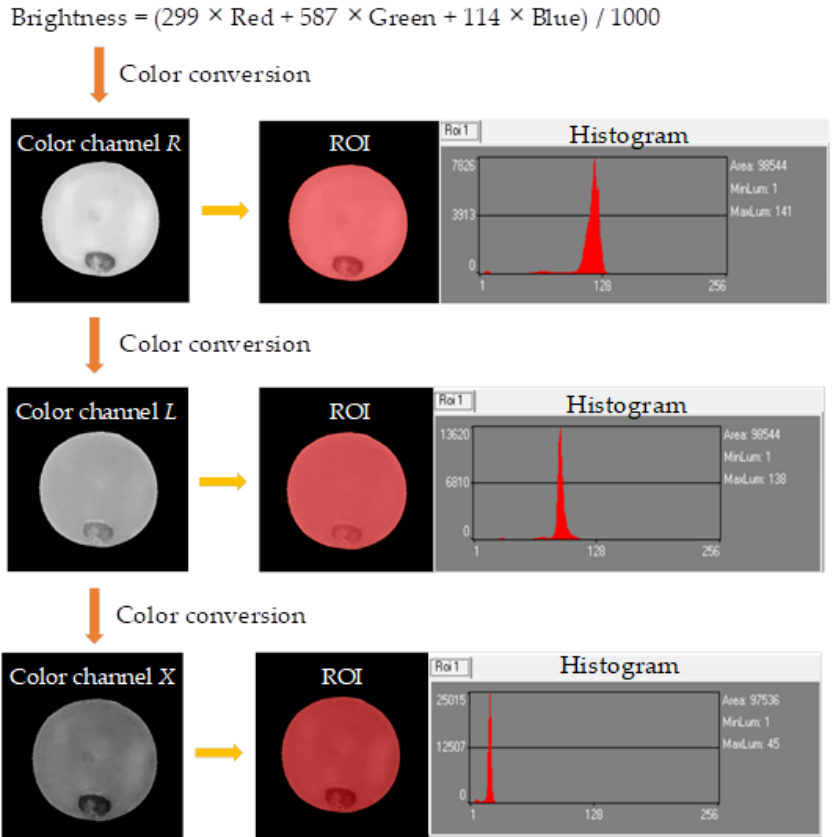
Figure 4. The color conversion of the original red currant image to selected color channels R , L , and X and the ROI determination.